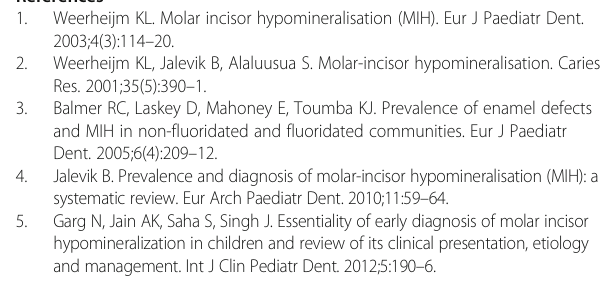
Abbreviation MIH: Molar incisor